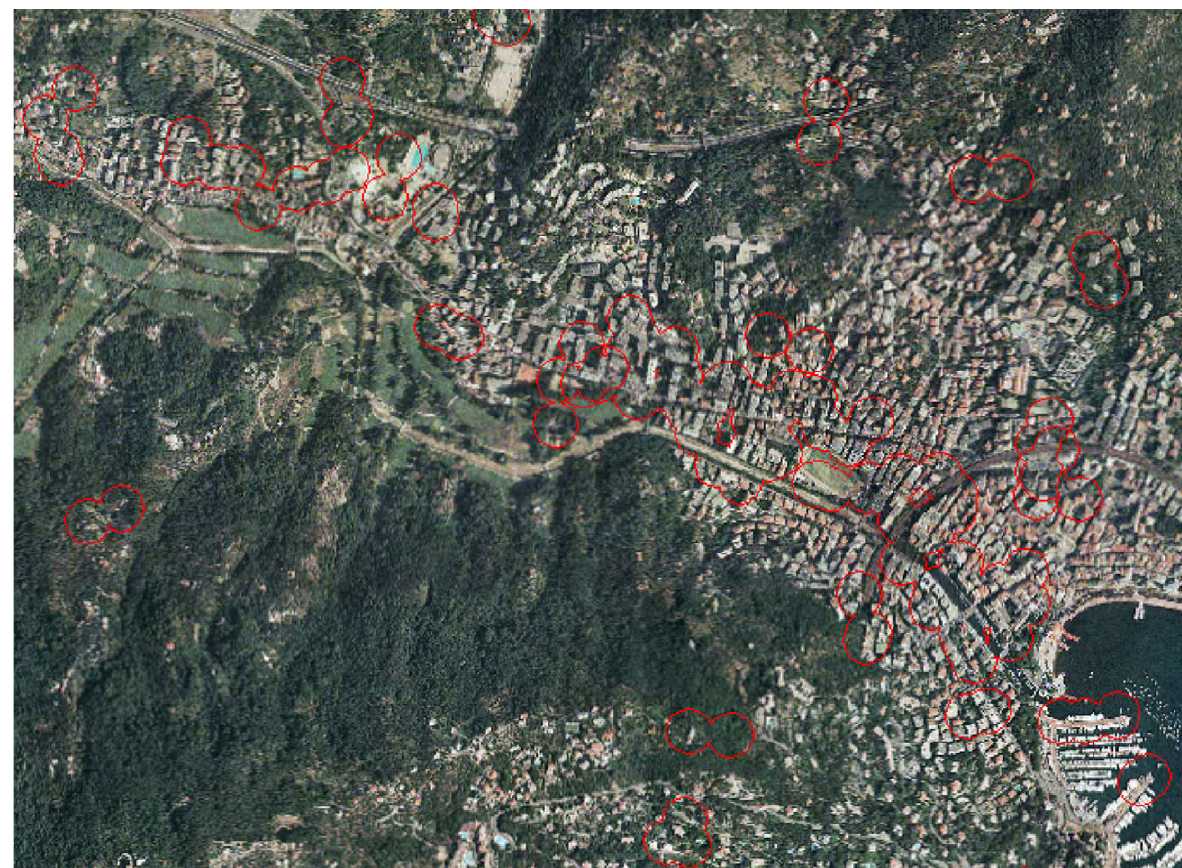
Fig. 15. Anomalous areas (red circles) detected in Rapallo floodplain by Risknat Project (DatasetPS_ENVI_D_ T208_F2709_RAPALLO,PS_ ERS_A_T487_F891_VARESE_LIGURE, PS_ERS_D_T208_F2709_CAMOGLI). (Available at RiskNET